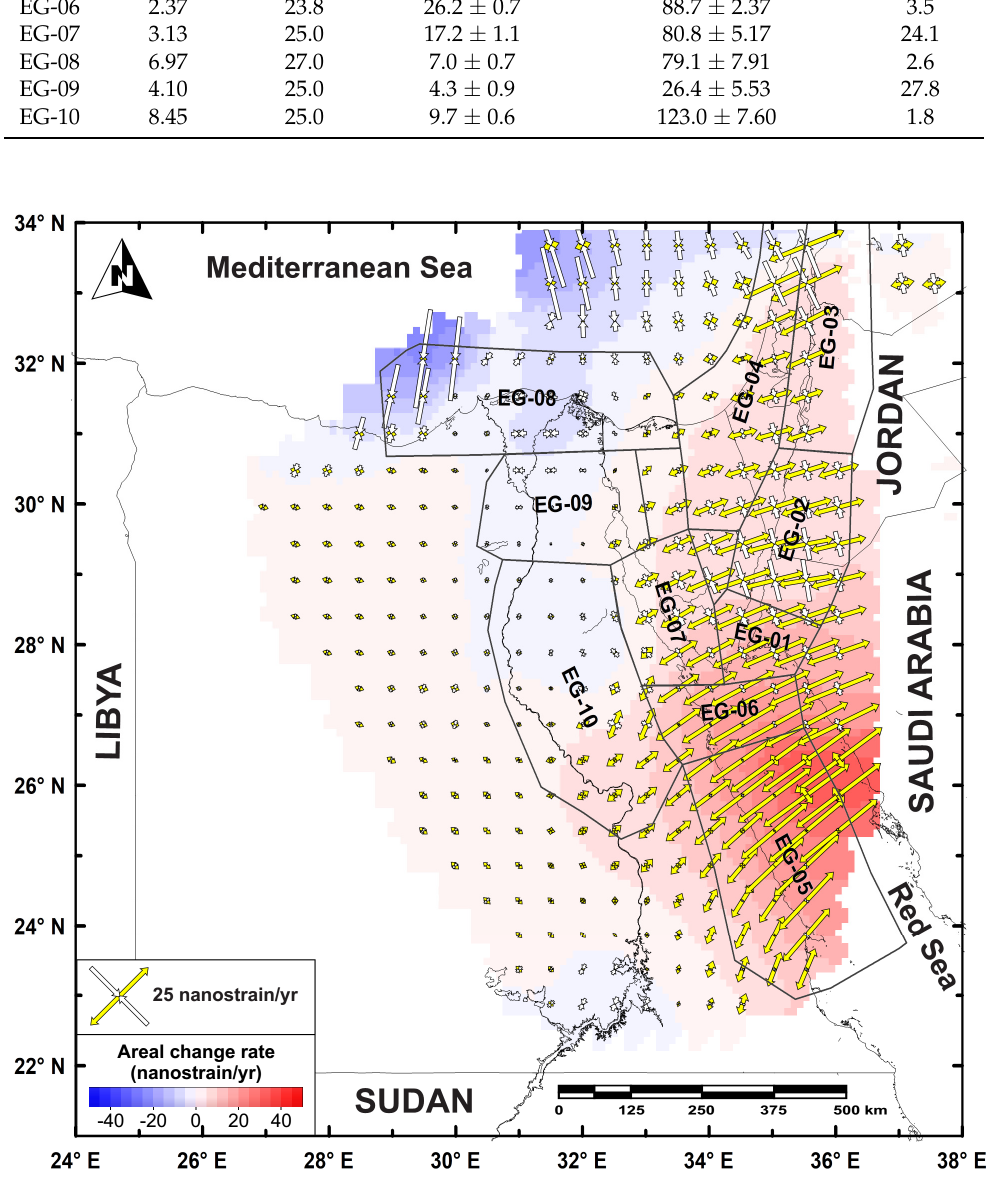
Figure 6. Geodetic strain-rate field (after [61]) overlain by the defined seismic sources. Color scale range (from blue to red) in the background of the plot shows the areal change in the strain-rate field, while the arrows refer to the maximum extensional (in red) and maximum contractional (in blue) horizontal strain-rates.